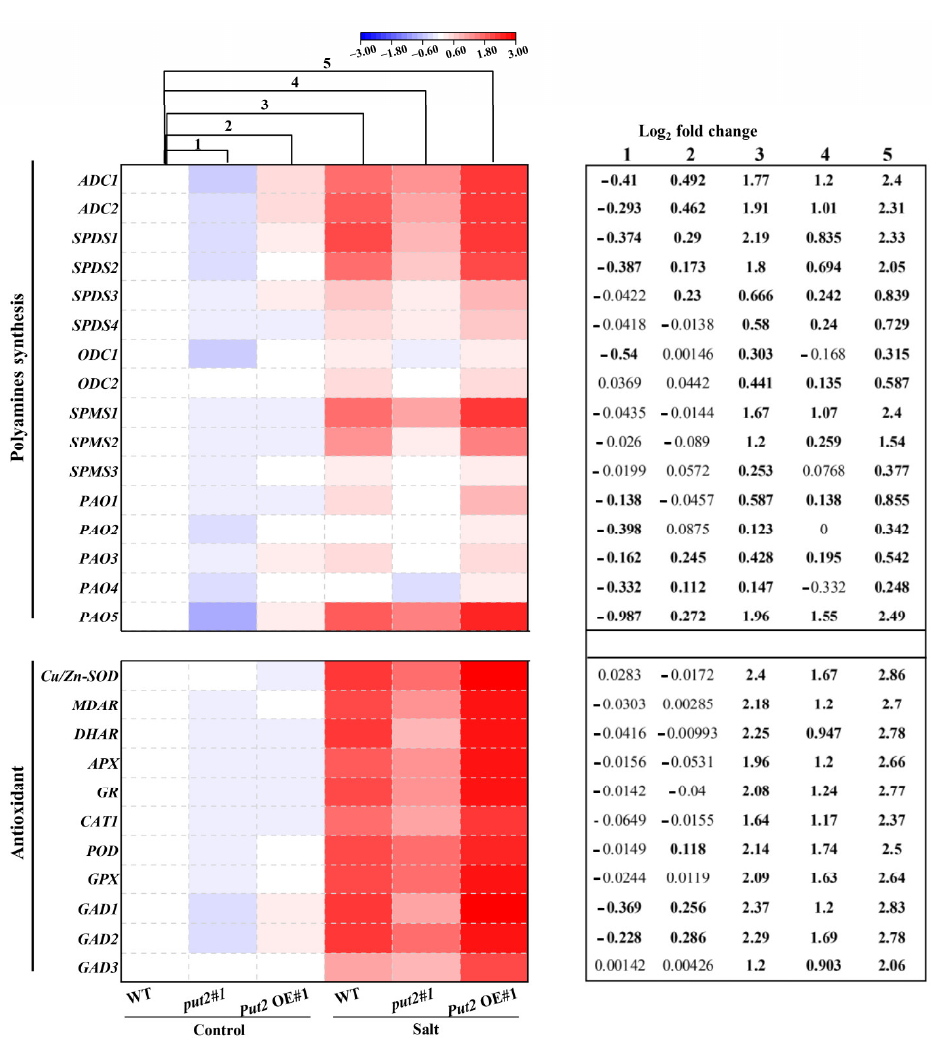
Figure 8. Put2 positively mediates the expression of polyamine synthesis and antioxidant enzyme- encoding genes. Heatmap of polyamine synthesis and antioxidant enzyme-encoding genes. Levels were differentially modified in put2 vs. WT plants, and Put2 OE vs. WT plants under normal conditions or salinity stress. Log 2 fold changes (relative to expression levels in sample of WT plants under control treatment) are shown with a color scale. A chart on the right side of the heatmap shows log 2 fold change of expression levels in put2 (mutant) compared to those in WT plants before salt treatment (column 1), log 2 fold change of expression levels in Put2 OE (overexpression) compared to those in WT plants before salt treatment (column 2), log 2 fold change caused by salinity treatment in WT plants (column 3), and log 2 fold change caused by salinity treatment in put2 (column 4) or Put2 OE (column 5). Statistically significant differences are indicated in bold font ( p < 0.05).